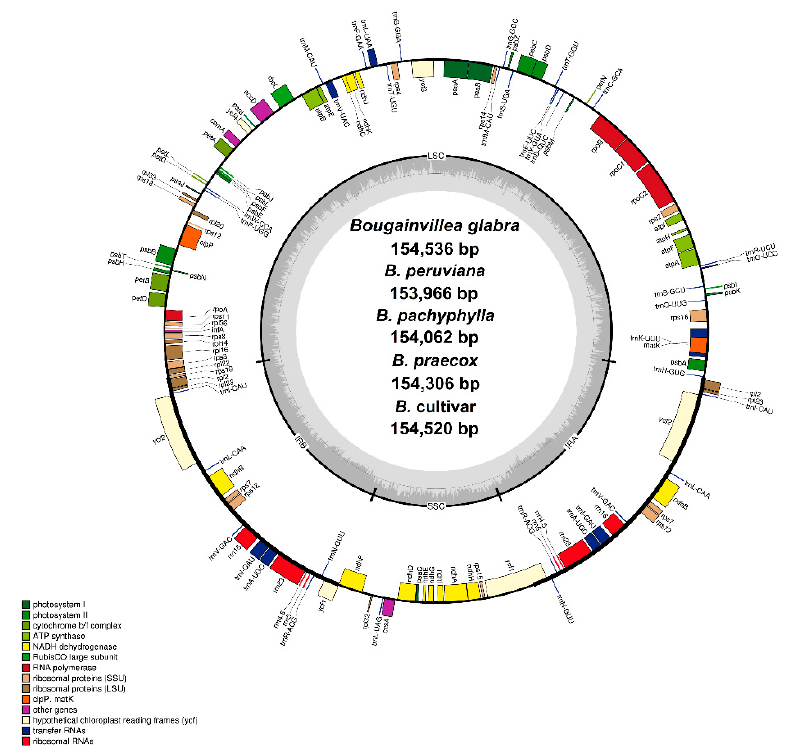
Figure 1. Circular gene map of five newly sequenced Bougainvillea chloroplast genomes. The genes drawn outside the circle are transcribed clockwise, while the genes on the inside are transcribed counterclockwise. Genes belonging to di ff erent functional groups are color-coded. The dark gray plot in the inner circle represents the GC (Guanine-Cytosine) content, whereas the light-grey corresponds to the AT (Adenine-Thymine)